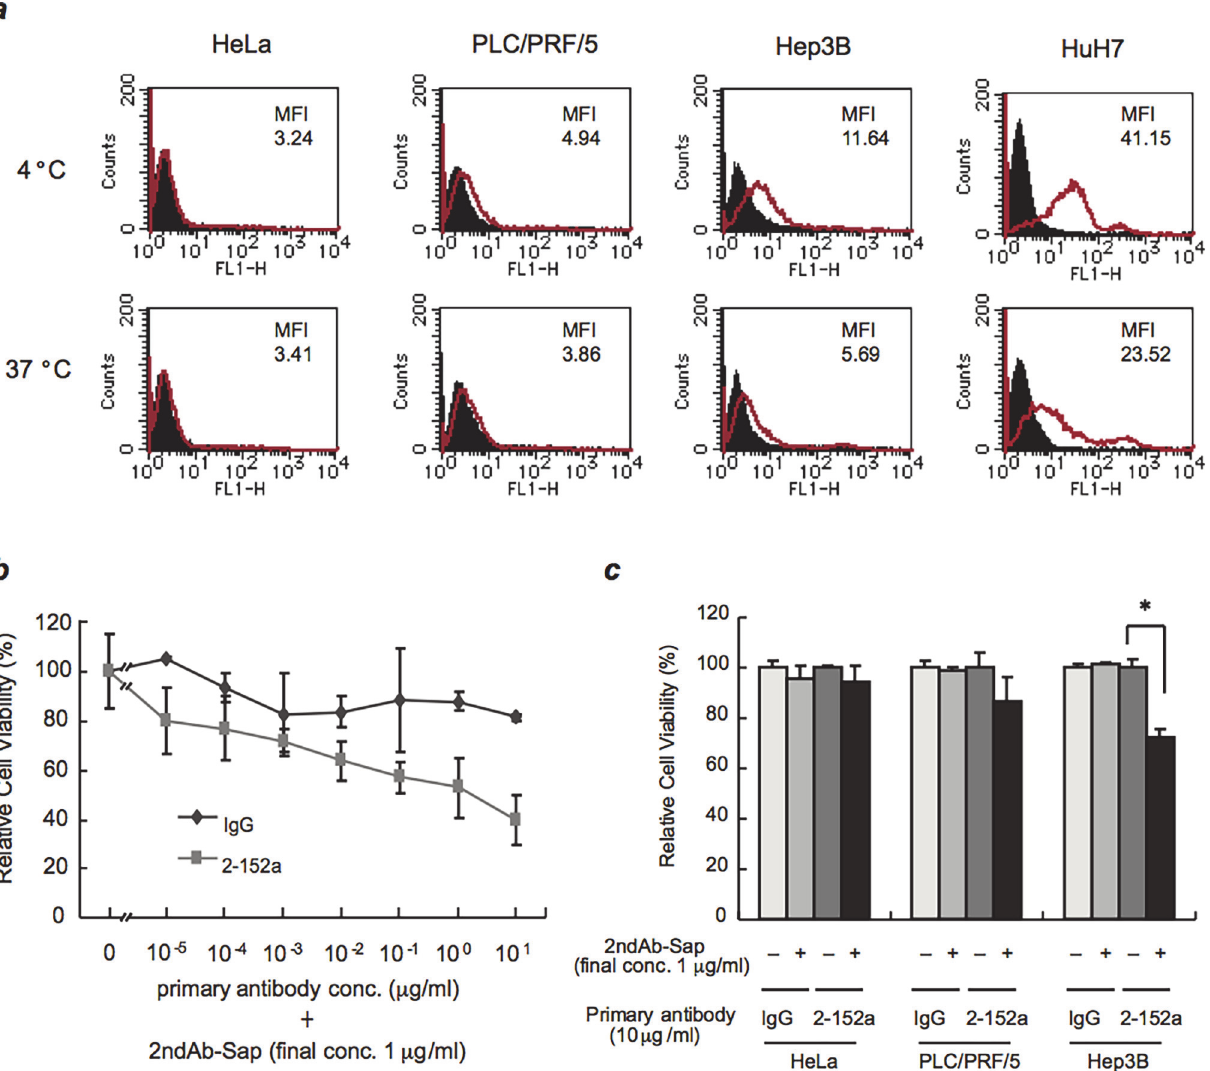
Fig 6. Specific uptake mediated by cell-surface DHCR24. ( a ) HCC cell lines (HuH-7, Hep3B, and PLC/PRF/5) and HeLa cells were incubatedwith 2-152a MAb at 4°C (a temperature that inhibits endocytosis) or 37°C (physiological temperature) for 2 h, and then incubatedwith anAlexa Fluor 488-conjugated goat anti-mouse IgGat 4°C for 1 h. The cells were then analyzed by flow cytometry. ( b ) HuH-7 cells were seeded at a density of 5 × 10 3 cells/well in 96-well tissue culture plates. After incubation for 24h, serial dilutions of 2-152a MAb or mouse IgG were added in the presence of saporin-conjugatedanti-mouse IgG (1 μ g/mL). After 72 h, cell viability was then assessed using the BrdU ELISA assay kit. Average viability was calculated relative to the viability of untreatedcells, which was set at 100%. ( c ) HeLa, Hep3B, and PLC/PRF/5 cells were treated with 2-152a MAb or mouse IgG (10 μ g/mL) in the presence or absence of saporin-conjugated anti-mouse IgG(1 μ g/mL). After 72 h, cell viability was determined using a BrdU ELISA assay kit. Percent viability was calculated relative to the viability of untreated cells, which was set at 100%. * , p <